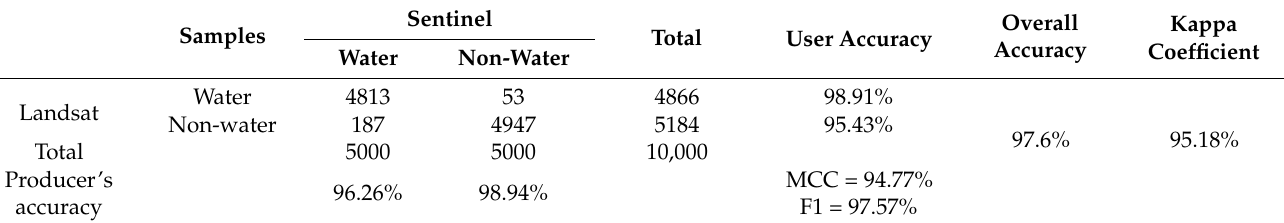
Table 3. Accuracy assessment of the sample